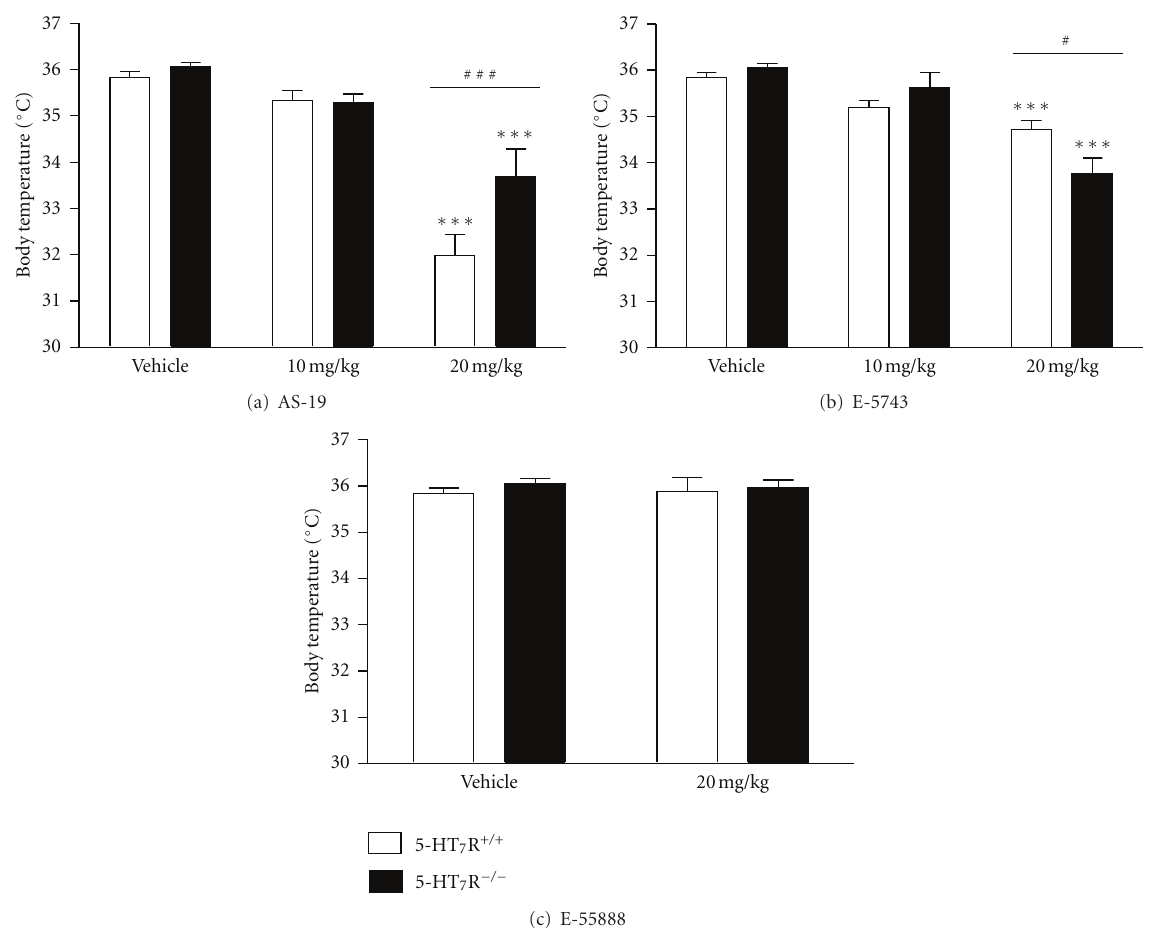
Figure 3: E ff ects of 5-HT 7 receptor agonists AS-19 (a), E-57431 (b), and E-55888 (c) on body temperature in wild-type and 5-HT 7 receptor knockout mice. Subcutaneous administration of AS-19 and E-57431 at 20mg/kg significantly reduced body temperature in both wild- type and 5-HT 7 receptor knockout mice and showed significant di ff erences between both genotypes. However, E-55888 at 20 mg/kg did not reduce the body temperature neither in wild-type nor in 5-HT 7 knockout mice. Each bar represents the mean ± S.E.M. ( n = 8–12). ∗∗∗ P < 0 . 001 versus vehicle corresponding group; # P < 0 . 05; ### P < 0 . 001 versus corresponding dose in 5-HT (Bonferroni multiple comparison test